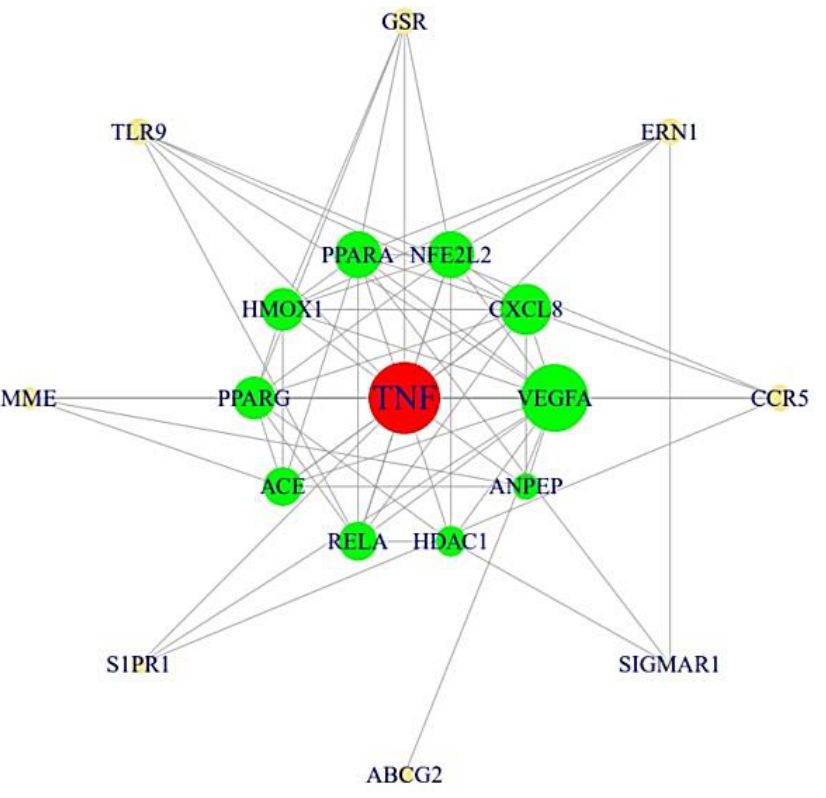
Figure 4. The PPI networks (19 nodes and 69 edges).